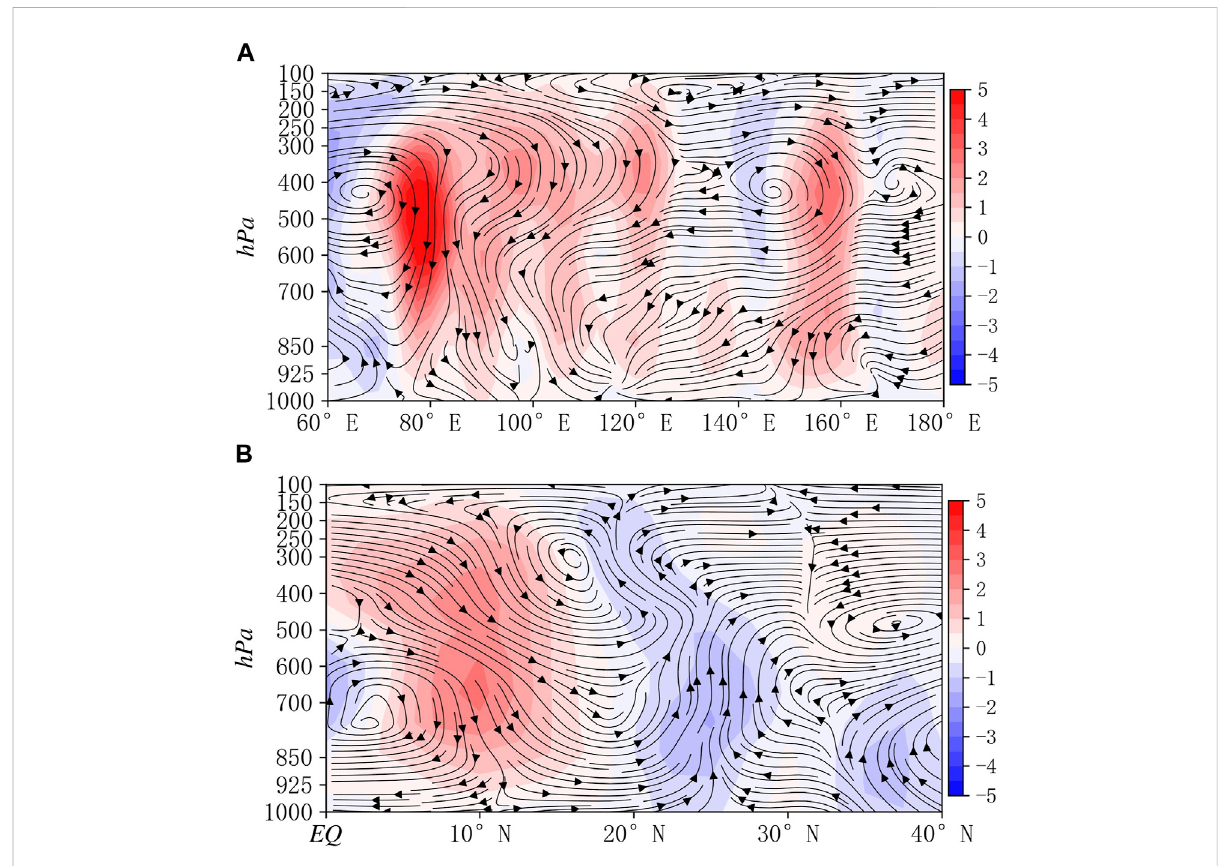
FIGURE 10 Interdecadal differences between P1 and P2 periods: Walker circulation (0 ° -10 ° N average) (A) ; Hadley circulation (100 ° – 120 ° E average) (B) . Shaded: vertical velocity (note that vertical velocity is multiplied by 100 for better